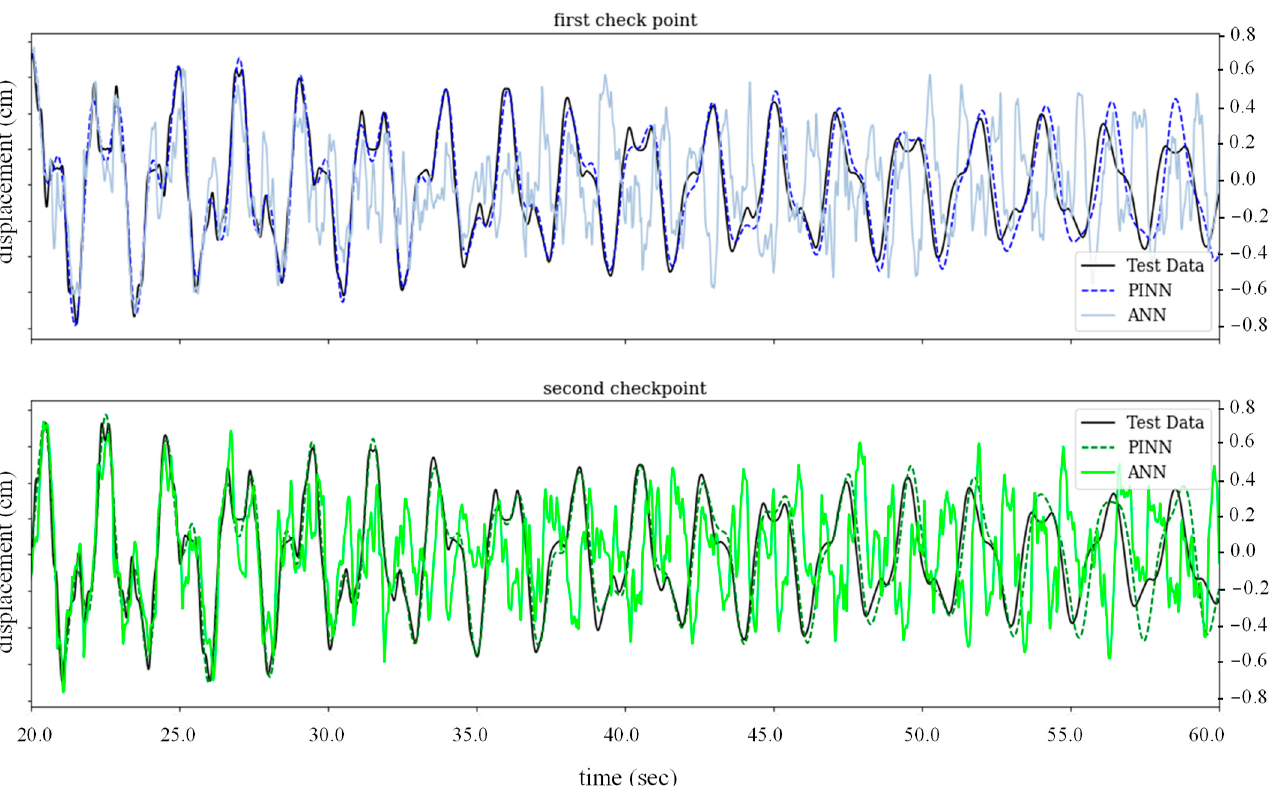
Figure 26. PINN and ANN state estimation at the checkpoints with modified hidden layers for the test period.